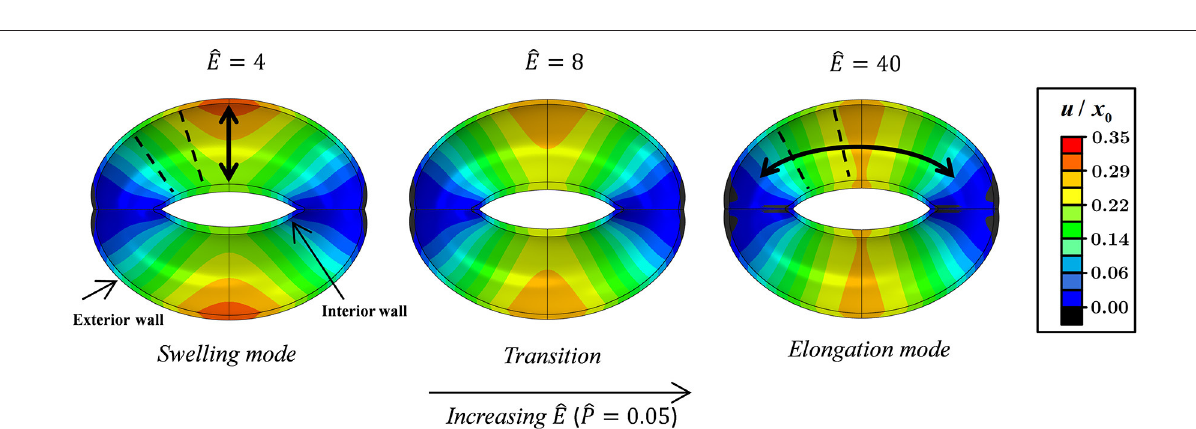
10 (see also Supplementary Video S1). =